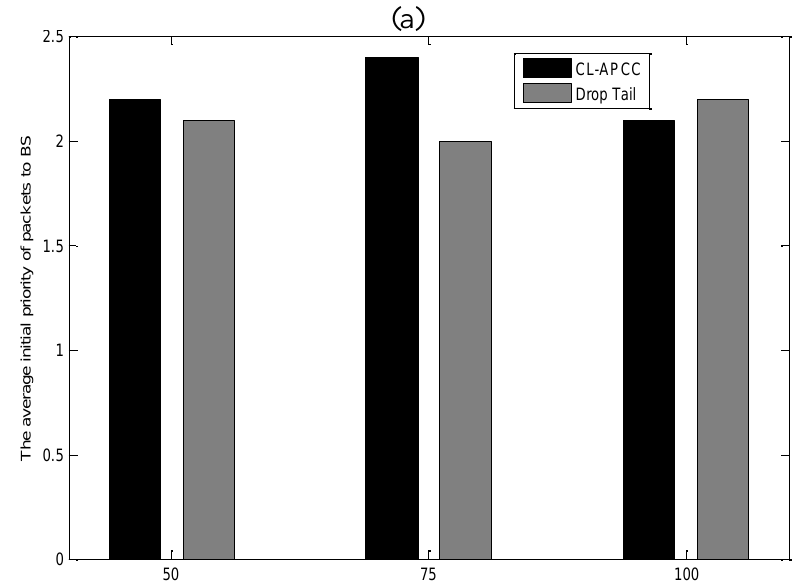
Figure 17. (a) The average initial priority of packets to BS; (b) The average sending priority of packets to